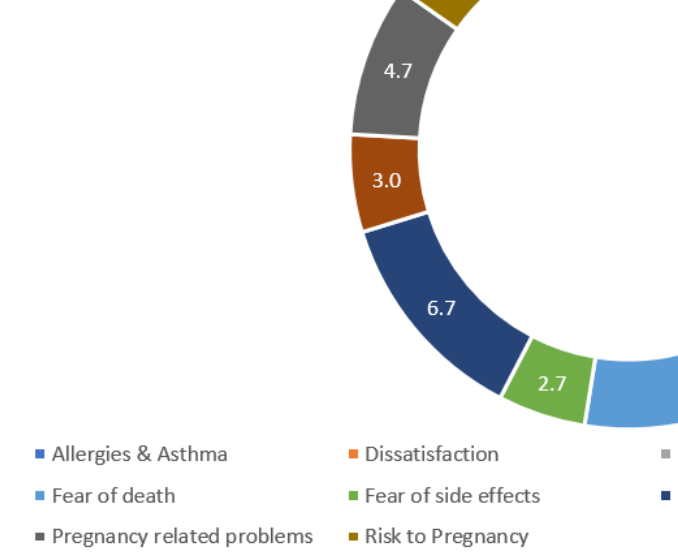
Table 5. Astonishingly, about half of the participating women (49.7%, n = 113) agreed that